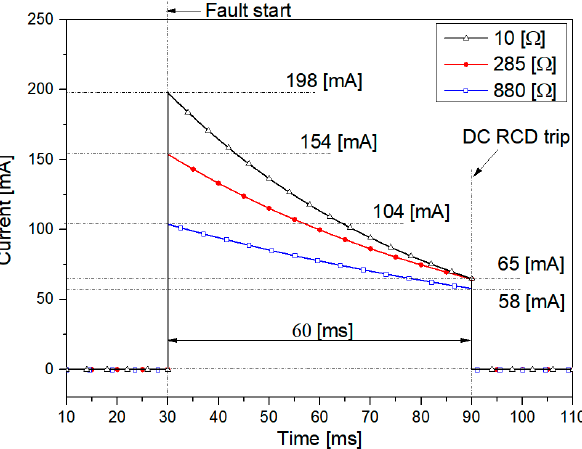
Figure 15. Waveform of the fault current for a ground fault with a 10 Ω impedance and the electrical shock corresponding to current paths 12 and 13.